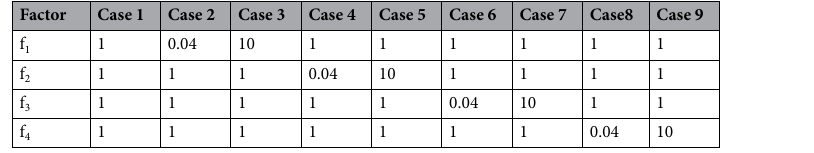
Table 3. Factors of forward non-ionization reaction